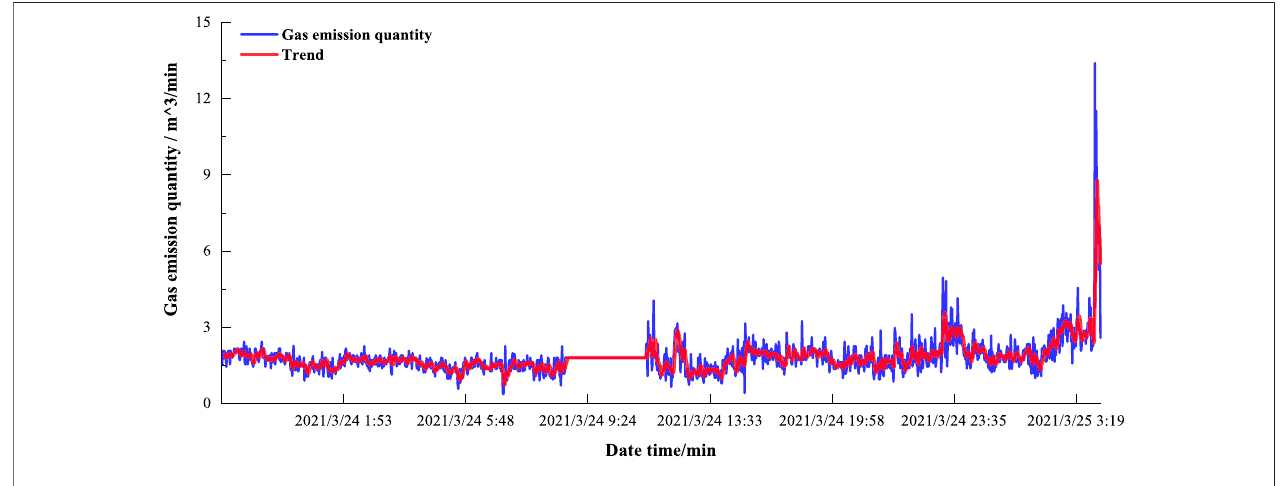
FIGURE 8 | Gas emission quantity moving average curve.